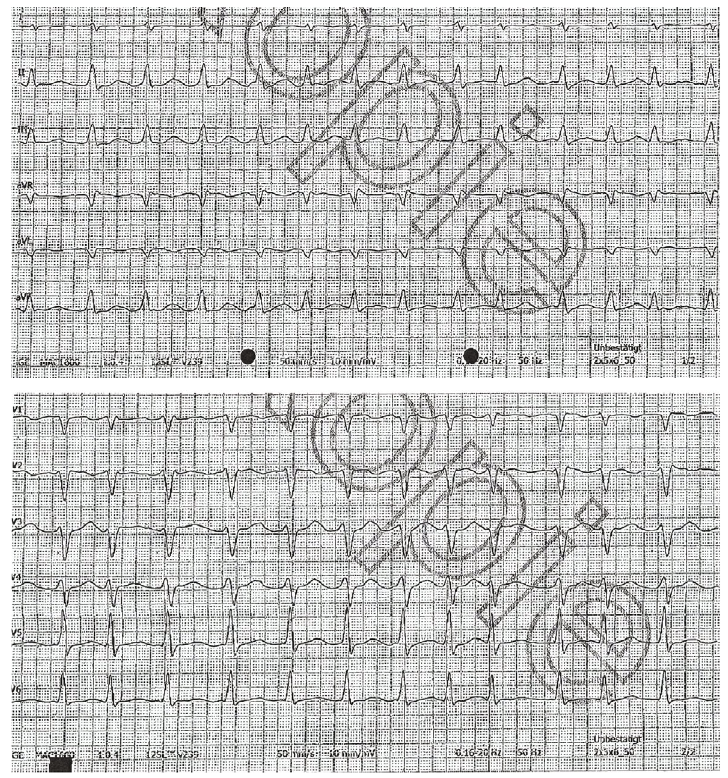
Figure 1: ECG on admission showing tachyarrhythmic atrial fi brillation with 158